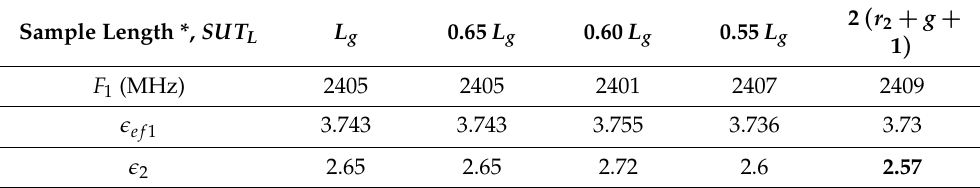
Table 3. Analyzing resonant frequencies for full sample width ( SUT W = W g ) and variable sample length, SUT L .